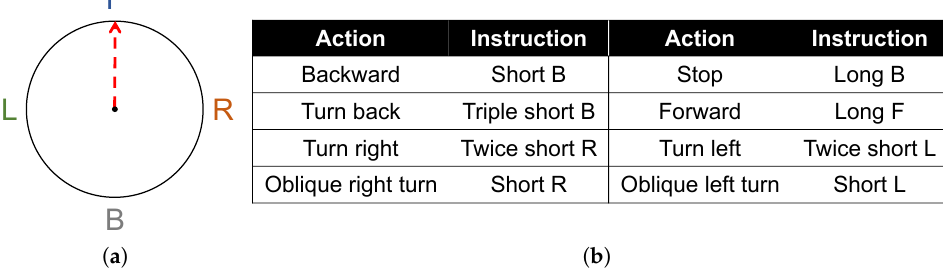
Figure 7. Navigation code of the neck ring device. Take “forward” as an example. ( a ) Stereoscopic perception of forward command on the neck ring. ( b ) Navigation codes corresponding to neck